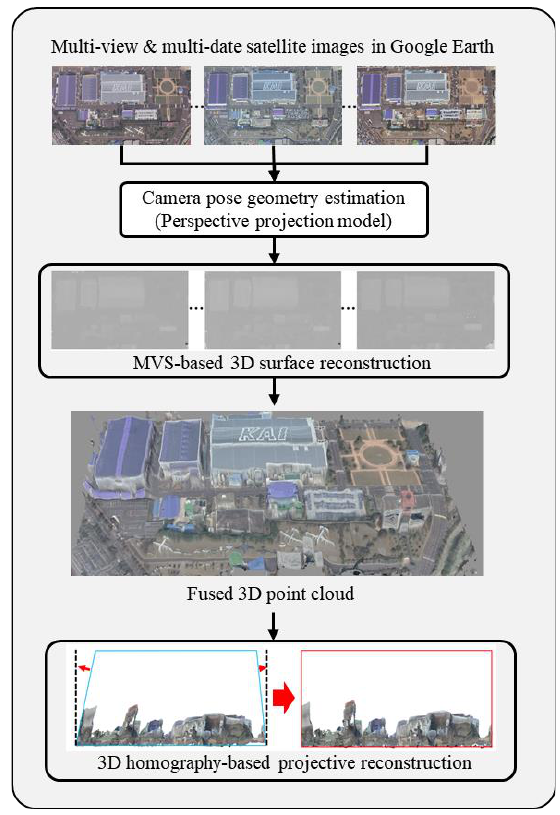
Figure 2 . The proposed multi-view and multi-date satellite 3D reconstruction scheme.